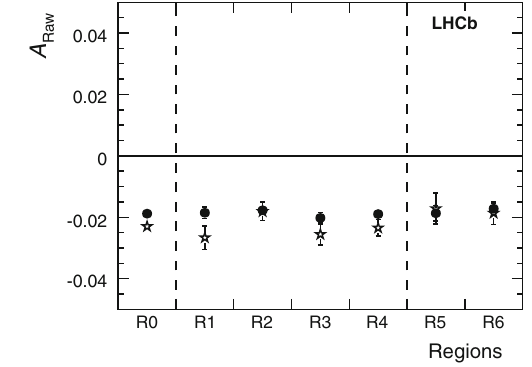
Fig. 4 Measured values of A Raw in regions of Λ + c → pK − π + can- didate decays for 2011 (stars) and 2012 (dots) data samples. R0 corre- sponds to full Dalitz plot and R2 is separated into R5 and R6, and these regions are correlated and separated by dashed lines